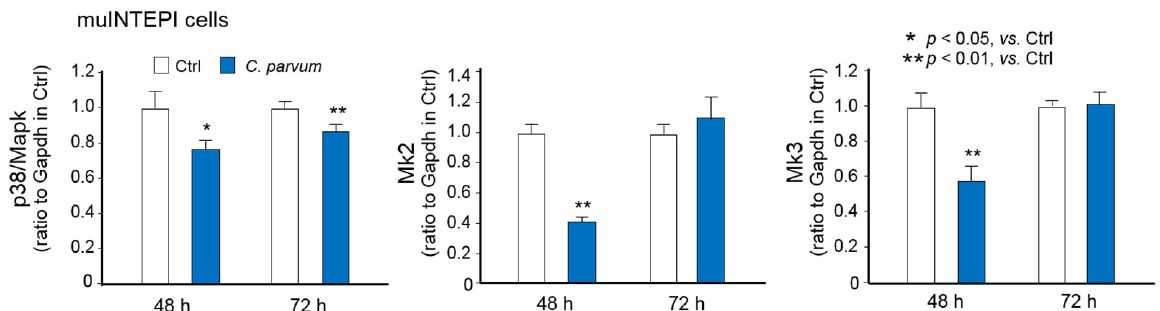
Figure 5. Downregulation of p38 / Mapk , Mk2 and Mk3 genes in mulINTEP1 cells following C. parvum infection. RNA levels of p38 / Mapk , Mk2 and Mk3 genes in mulINTEP1 cells following C. parvum infection. Cells were exposed to C. parvum infection for 48 and 72 h. RNA levels of p38 / Mapk , Mk2 and Mk3 genes were measured by using real-time PCR. Data represent three independent experiments.